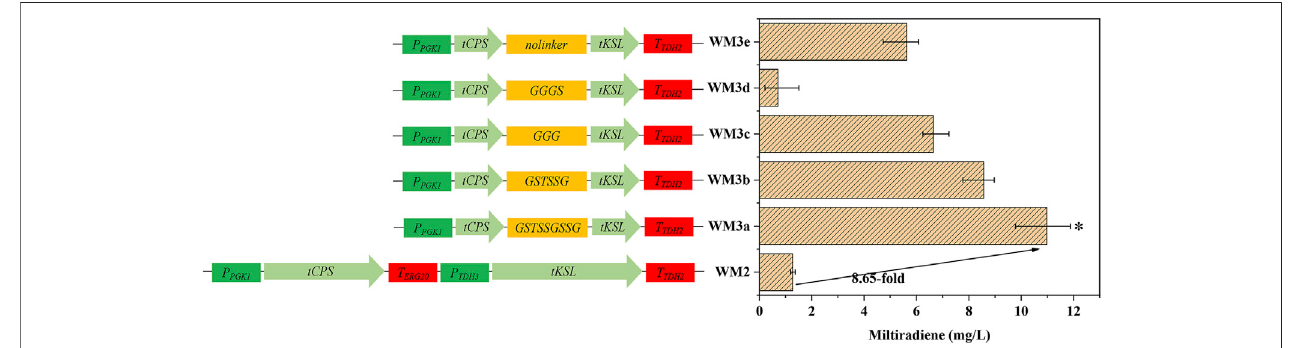
FIGURE 3 | Protein fusion and linker selection. WM2: Coexpression of tSmCPS and tSmKSL . WMa – e: Fusion of tSmCPS and tSmKSL using fi ve fl exible linkers: GSTSSGSSG, GSTSSG, GGG, GGGS, no linker. *: The product titer of strain WM3a was signi fi cantly higher than that of WM3b. * p < 0.05; ** p < 0.01; *** p < 0.001. Histograms illustrating the production of corresponding strains. Experiments were performed in